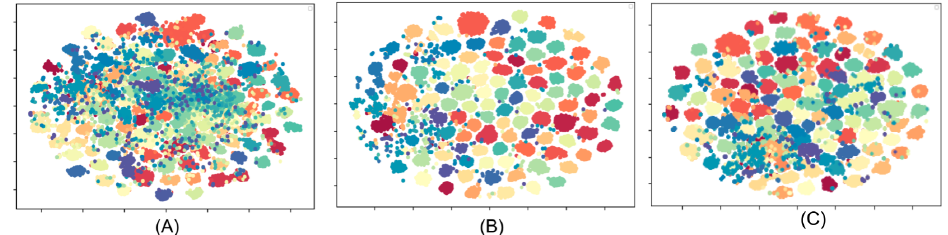
Figure 14. t-SNE visualization shows overlapping among the feature vectors of low-quality images extracted ( A ) from the model fine-tuned with pristine images, ( B ) model fine-tuned using all low- quality images and ( C ) model fine-tuned using our proposed strategy.